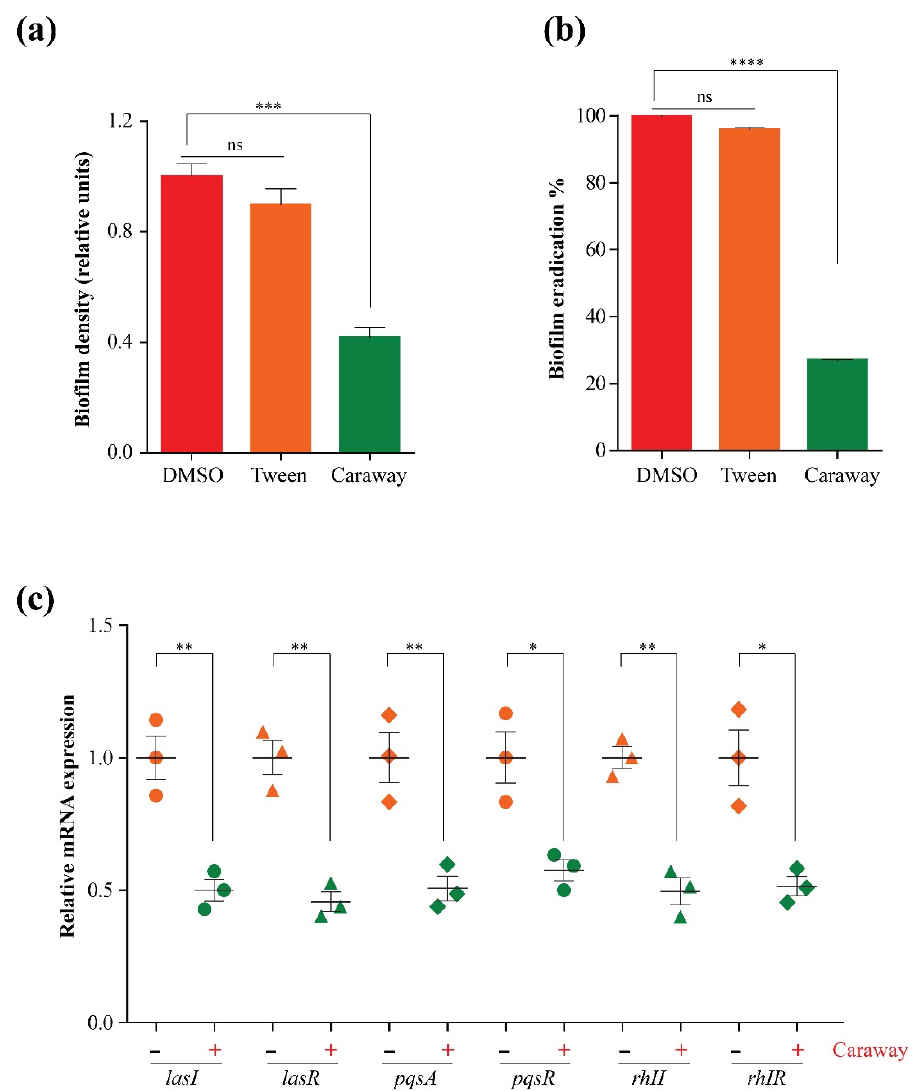
Figure 4. Effect of caraway oil on P. aeruginosa biofilm formation and in vitro biofilm eradication ( a , b ). qPCR analysis of quorum sensing genes expression in presence or absence of caraway essential oil ( c ), RopD was employed as a housekeeping gene. *, **, ***, and ****: significant change in caraway oil-treated group relative to untreated group at p < 0.05, ns denotes no